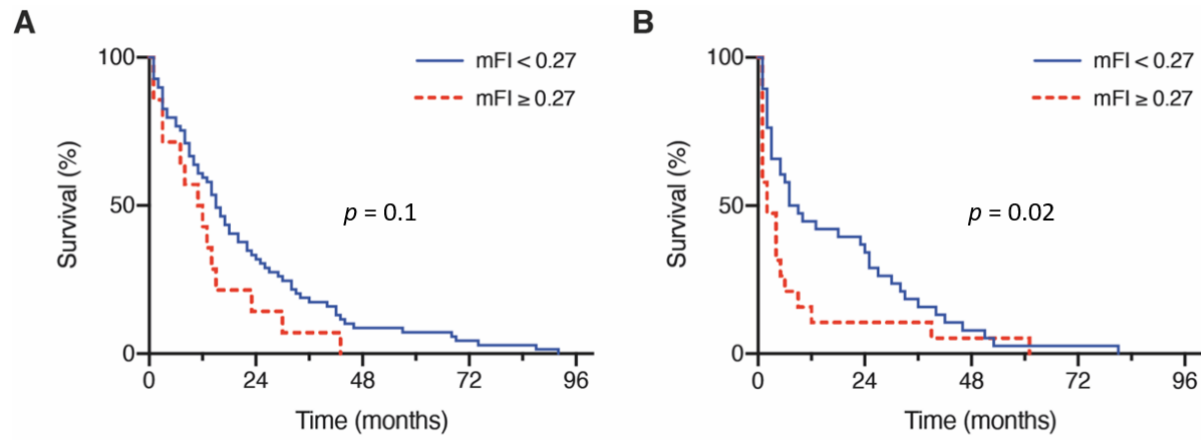
Figure 2. Patient frailty correlations to OS rates stratified for ( A ) patients aged < 65 y and ( B ) patients ≥ 65 y. y, years.